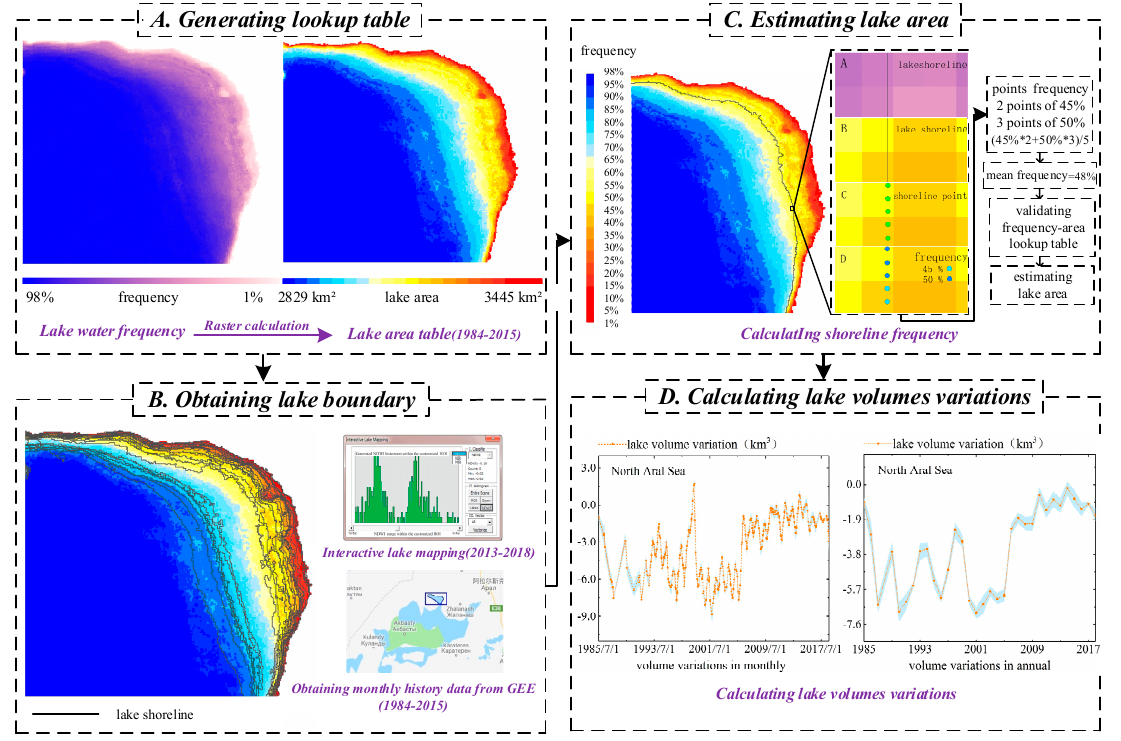
Figure 2. Workflow of the method proposed for reconstructing time series of lake area and volume variations including: ( A ) generating lookup tables, ( B ) extracting lakes boundary, ( C ) estimating lake areas, and ( D ) calculating lake volumes variations.